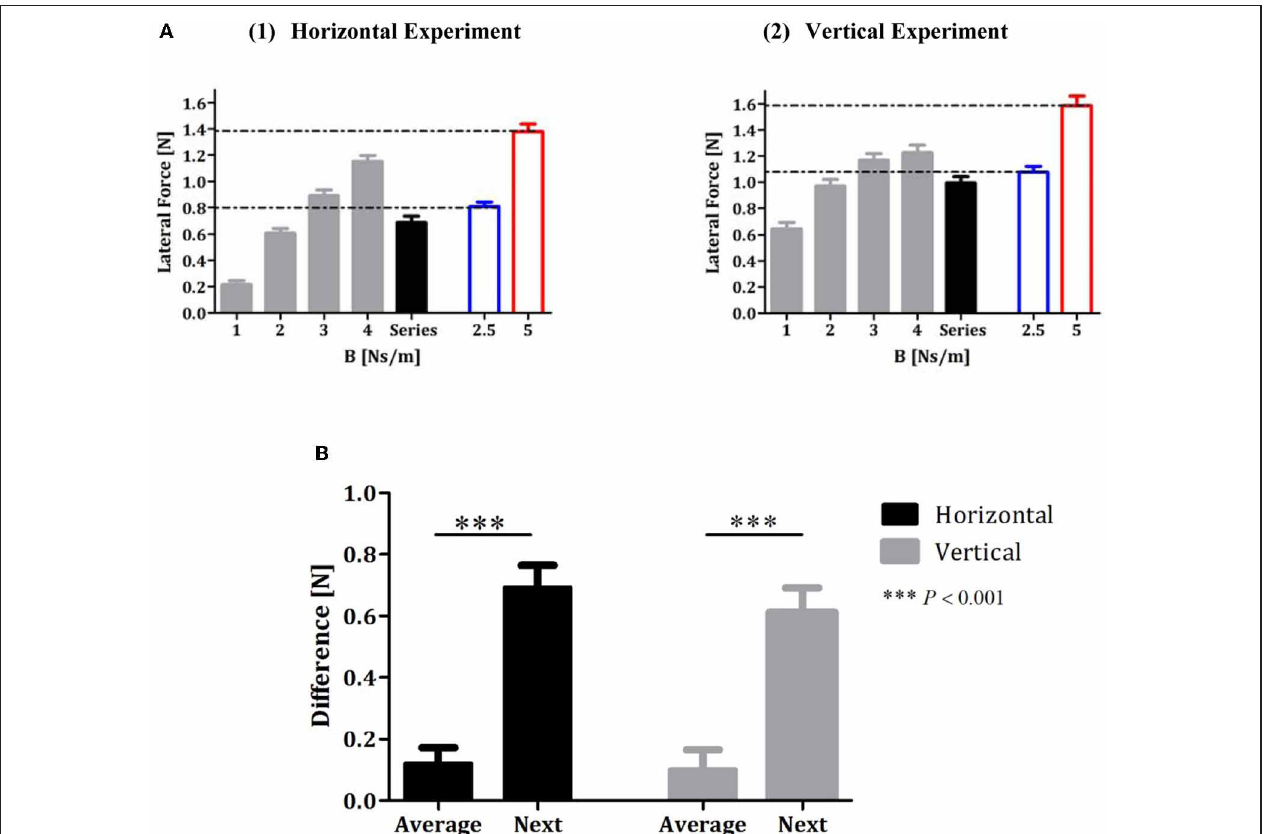
FIGURE 3 | Analysis of force profiles during adaptation to a series of force-fields. (A1 and A2) Lateral forces at maximum speed averaged across all subjects for horizontal and vertical experiments, respectively. The gray bars represent the forces during each condition of the constant-perturbations phase (1, 2, 3, and 4Ns/m), and the black bar represents the lateral forces in the error-clamp trials that followed the series trials in the random-perturbations